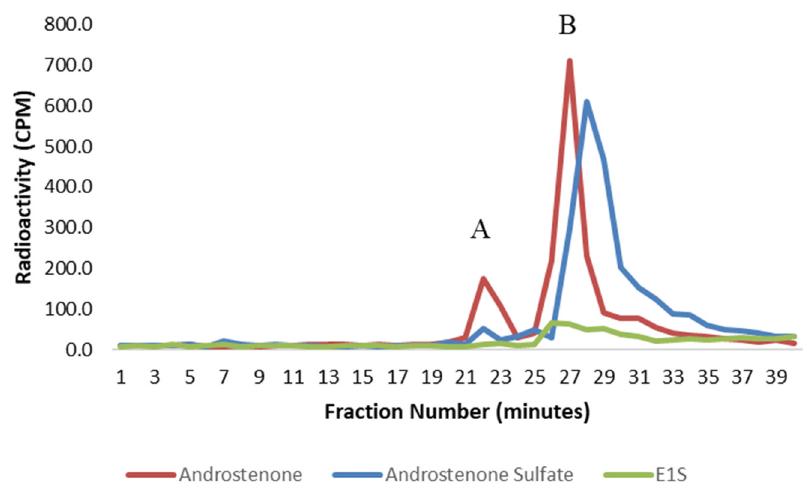
Figure 4. A graph showing the binding of free androstenone (red), androstenone sulfate (blue), and E 1 S (green) to albumin isolated from porcine plasma following HPLC gel filtration. Bound and unbound steroid peaks are represented by A and B, respectively. Values are expressed as the mean from two separate experiments.